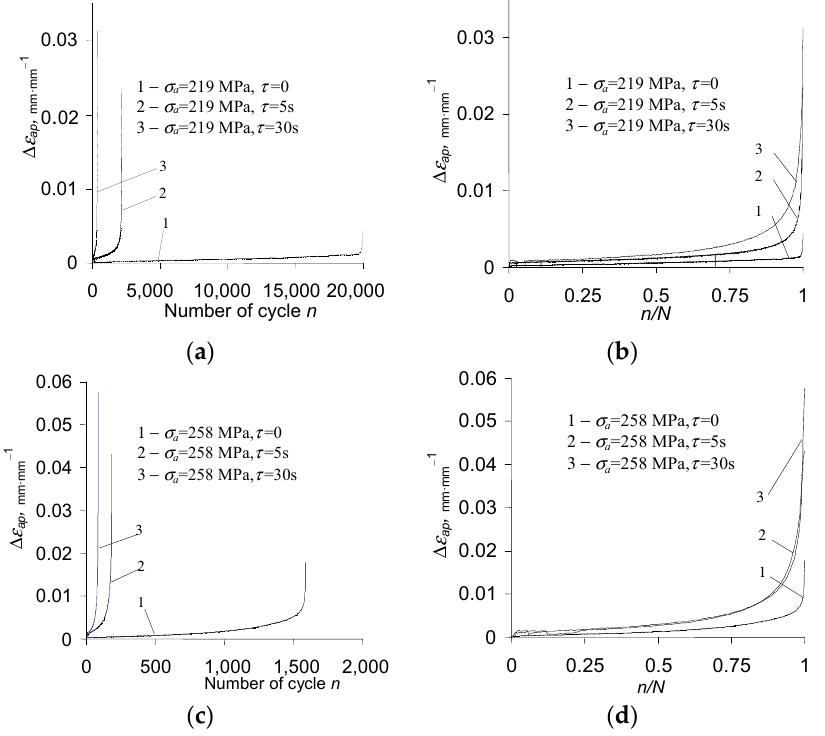
Figure 11. Changes in plastic strain on cycle ∆ ε ap for different stress amplitude levels: ( a , b ) σ a = 219 MPa; ( c , d ) σ a = 258